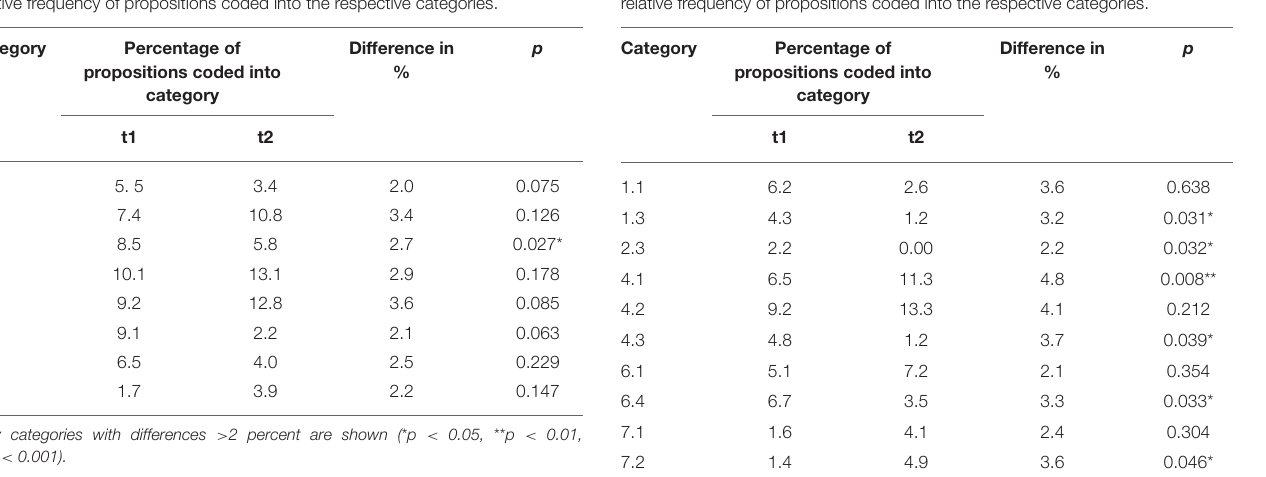
TABLE 2 | Ten most frequent categories for t1 and t2 (all participants and, in t2, divided into multi- and mono-professional teams). All participants t1 ( N = 97)